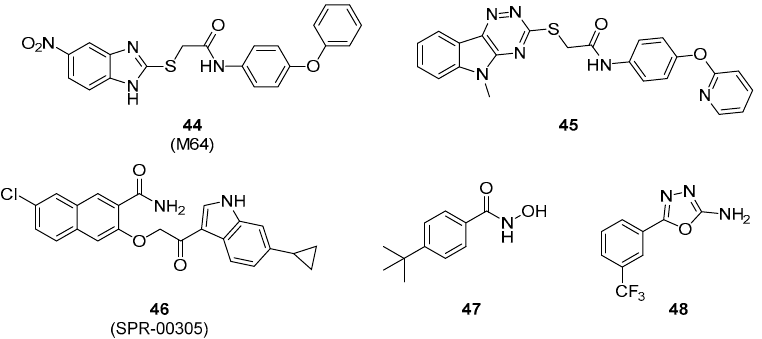
Table 5. Anti-QS and anti-virulence properties of AQ autoinducer non-analog QSIs.